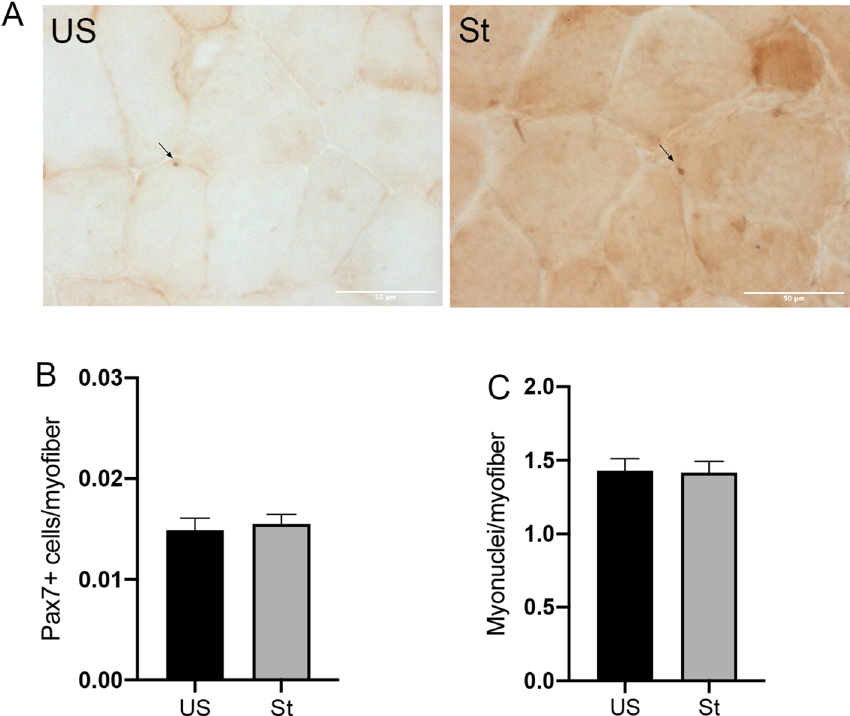
Quantification of the number of satellite cells (Pax7+ myonuclei/fiber) in gastrocnemius muscle. ( C ) Quantification of the number of myonuclei (myonuclei/myofiber) in gastrocnemius muscle. US unstretched, St stretched. Values are expressed as mean ± SEM. *P < 0.05, n =